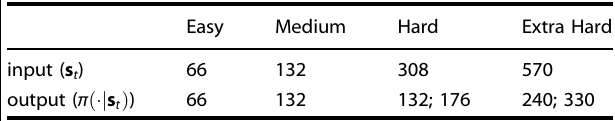
Table 5. Neural network input and output dimensions for all experiment dif fi culties.